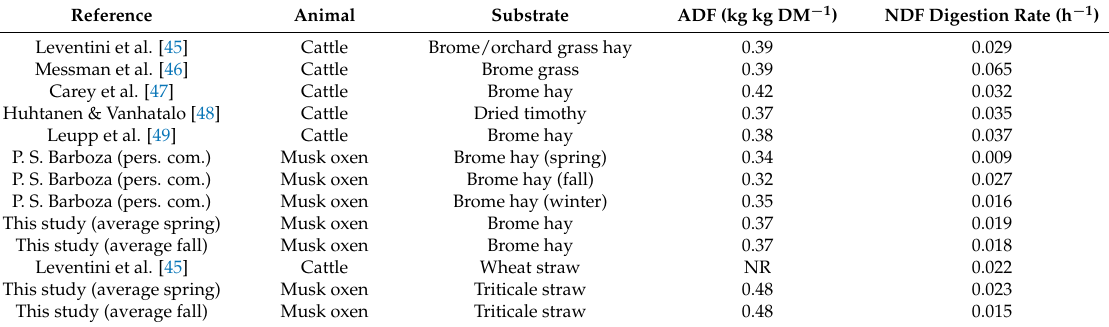
Table 6. Literature comparison of hay and straw NDF digestion